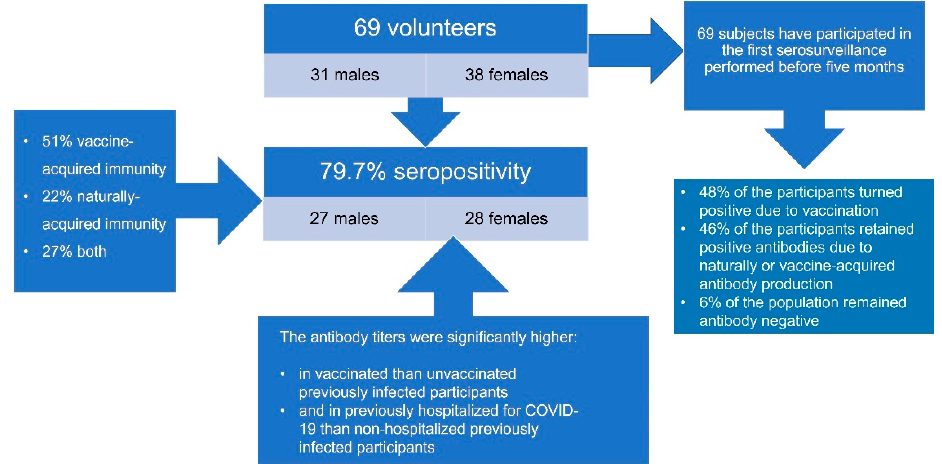
Figure 2. Analytic framework illustrating the methodology and main results of this study.